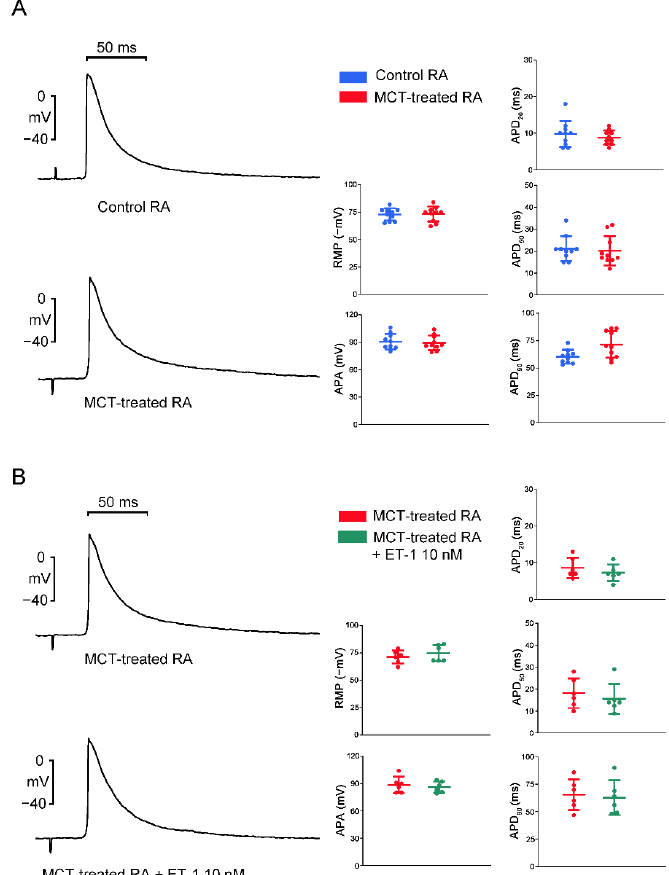
Figure 2. Action potential (AP) characteristics of the right atrial (RA) tissue preparations from control or monocrotaline (MCT)-treated hearts with or without endothelin (ET)-1 treatment. ( A ) Examples and average data of the APs of RA preparations from MCT-induced PAH rabbits (N = 10) and control rabbits (N = 10). ( B ) Examples and average data of the APs of RA preparations from MCT-induced PAH rabbits (N = 6) treated with or without ET-1 (10 nM). AP durations at 20%, 50%, and 90% repolarization of the AP amplitude (APD 20 , APD 50 , and APD 90 ) were measured at 2 Hz; AP amplitude, APA; RMP, resting membrane potential.